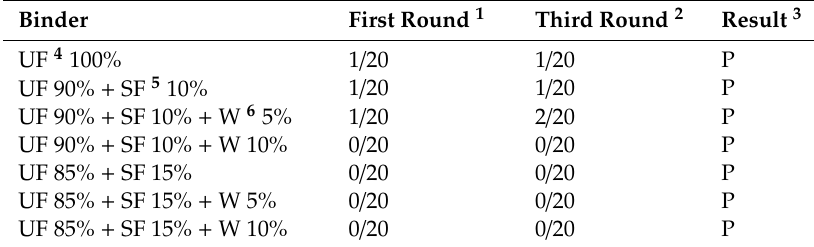
Table 3. Delamination test on plywood produced with different binders and with the addition of wollastonite. Binder First Round 1 Third Round 2 Result 3 UF 4 100% 1/20